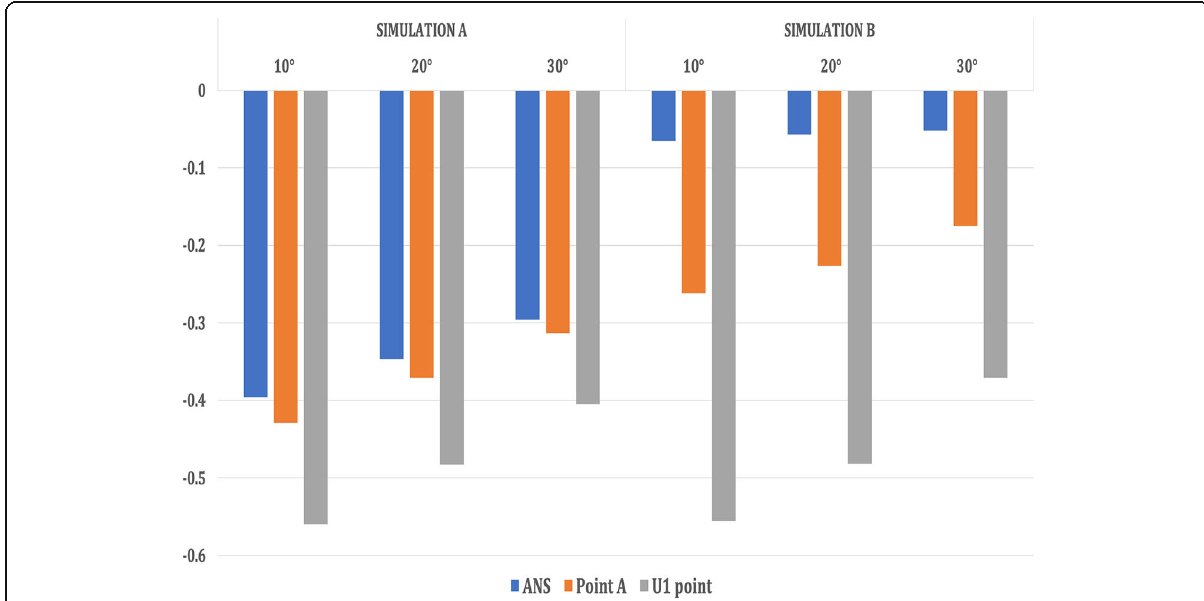
Fig. 6 Antero-posterior displacement of the maxillary landmarks when 250 g of force was applied at the three angulations (10° to 30°)